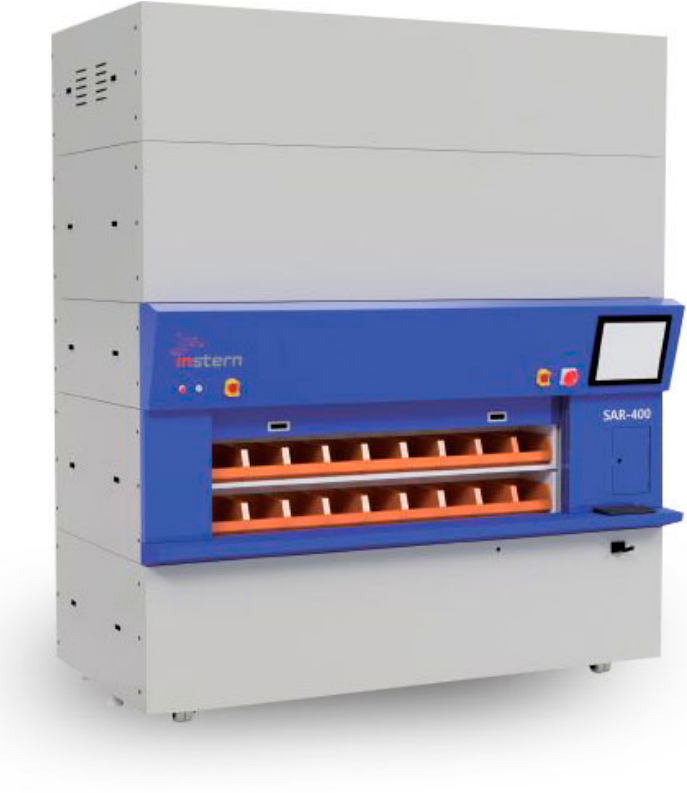
Figure 3. AS/RS configuration. Figure 3. AS/RS Table 1. Material Properties.